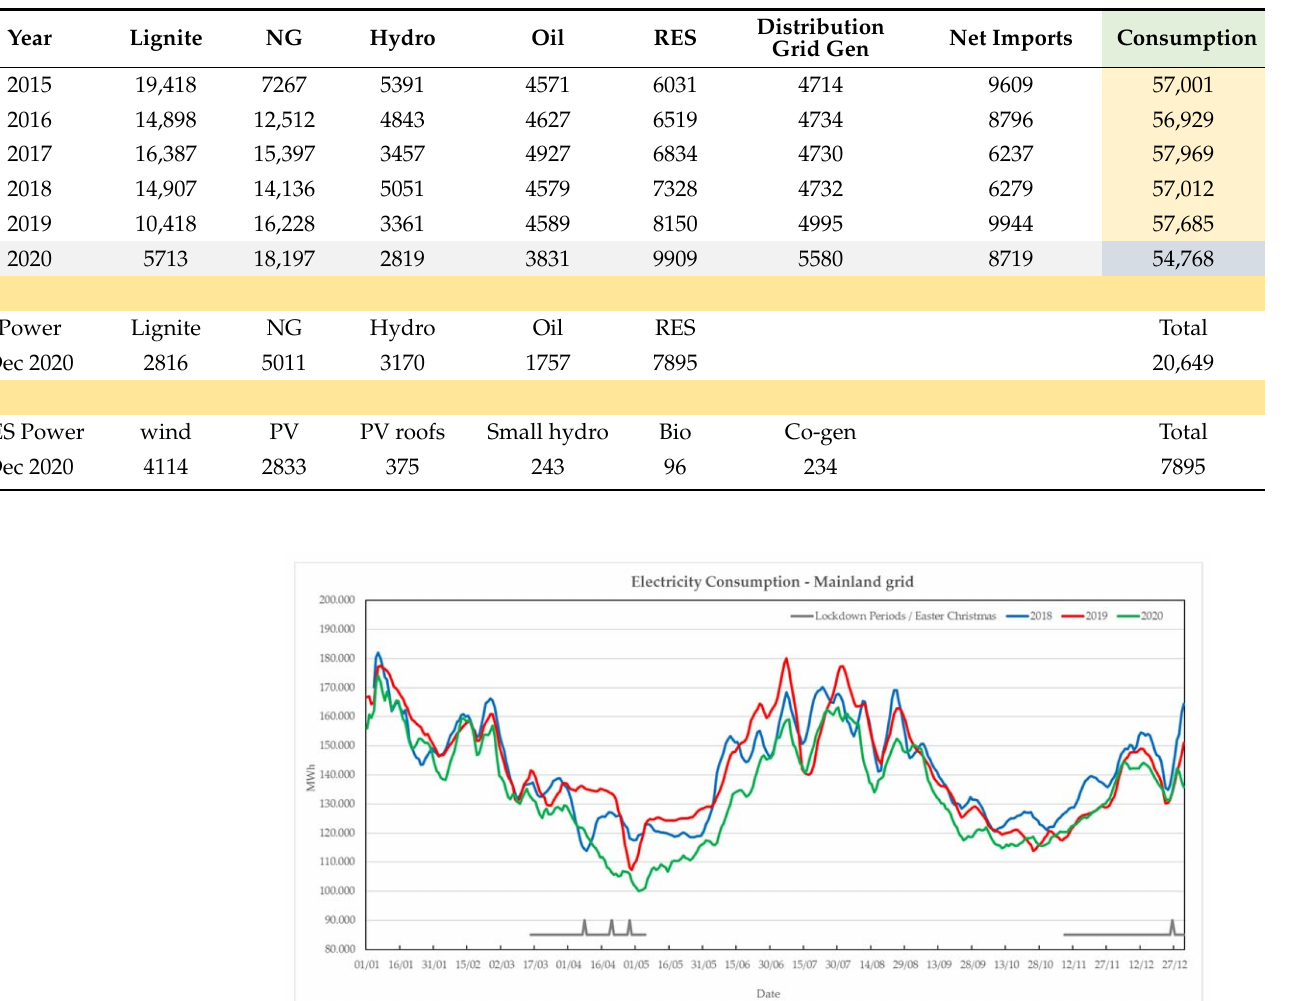
Table 3. Electricity generation, consumption (GWh), and power (MW).